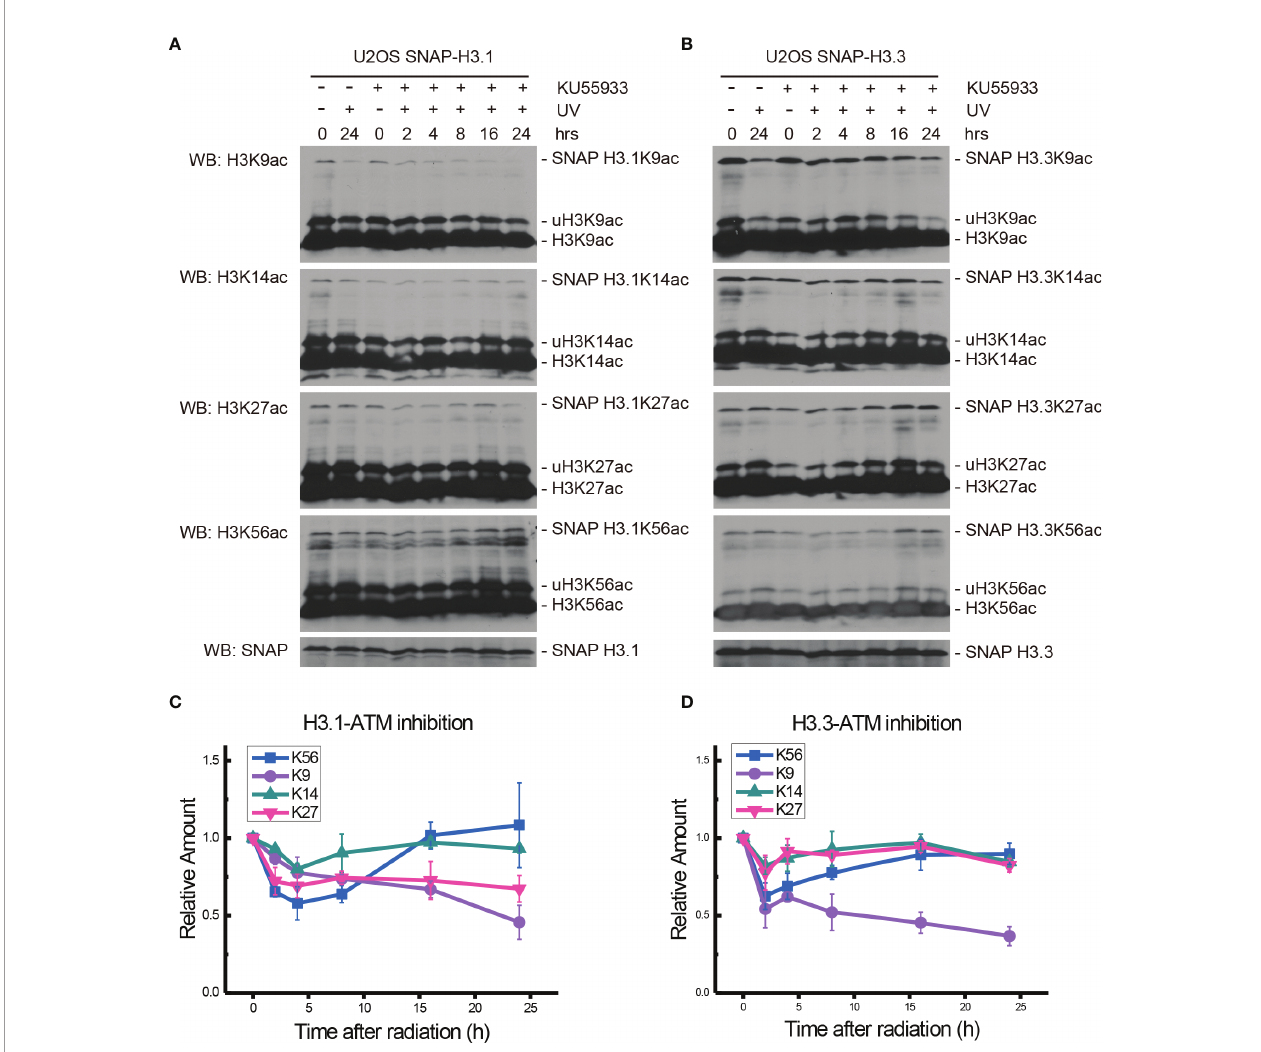
FIGURE 2 | Modulation of acetylated K9, K14, K27, and K56 of histone H3.1 or H3.3 by the ATM inhibitor KU55933 and UV radiation. (A) H3.1-SNAP U2OS cells were pretreated with DMSO (-) or KU55933 (+) for 1 h and then irradiated with 20 J/m 2 UV radiation. The insoluble nuclear protein samples were collected at 0 h, 2 h, 4 h, 8 h, 16 h, and 24 h after radiation. The acetylation levels of H3K9, H3K14, H3K27, and H3K56 were examined. SNAP-tagged histone H3 was used as an internal reference. (B) H3.3-SNAP U2OS cells were pretreated with DMSO or KU55933 and then irradiated with 20 J/m 2 UV radiation. The insoluble nuclear protein samples were collected, and the acetylation levels of H3K9, H3K14, H3K27, and H3K56 were examined. SNAP-tagged histone H3 was used as an internal reference. (C) Time- course alteration of acetylated K9, K14, K27, and K56 of histone H3.1 after 20 J/m 2 UV radiation and KU55933 treatment. The data are normalized immunoblotting results by ImageJ analysis from three separate experiments. (D) Time-course alteration of acetylated K9, K14, K27, and K56 of histone H3.3 after 20 J/m 2 UV radiation and KU55933 treatment. The data are normalized immunoblotting results by ImageJ analysis from three separate